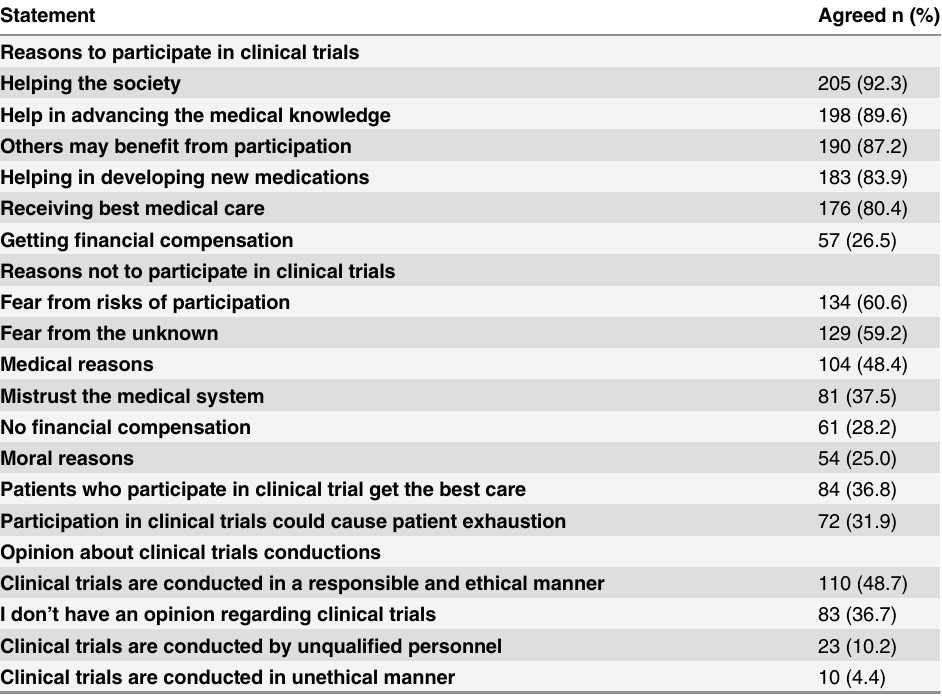
Table 5. Perceptions of study population towards participating in clinical trials.